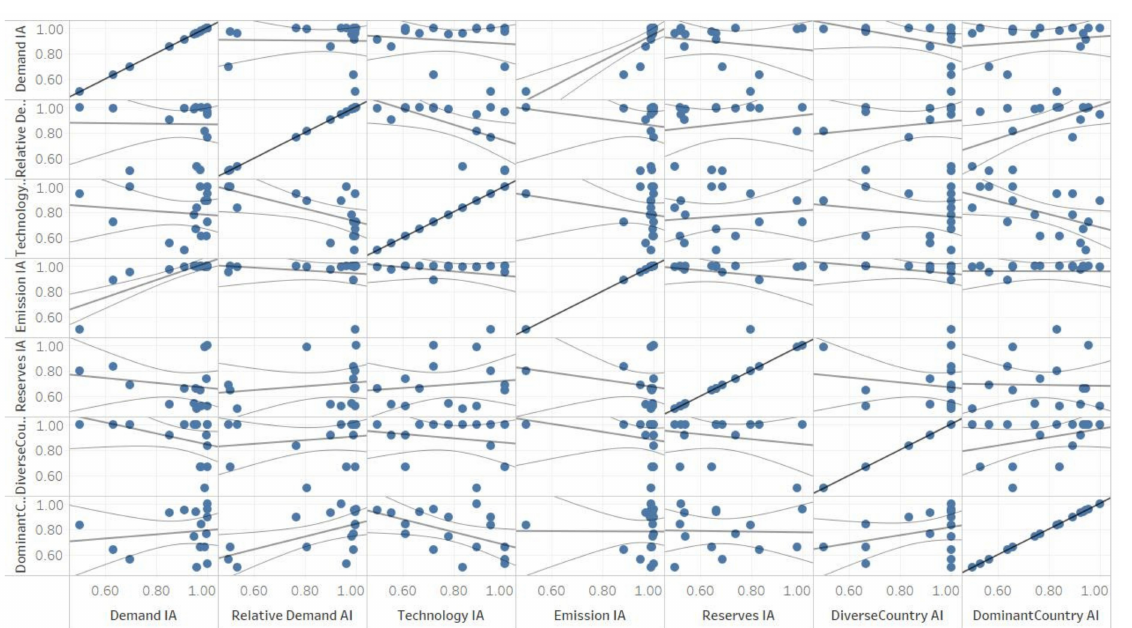
Figure A9. Cross-correlation scatterplot of availability indices. Grey lines correspond to linear trend and confidence